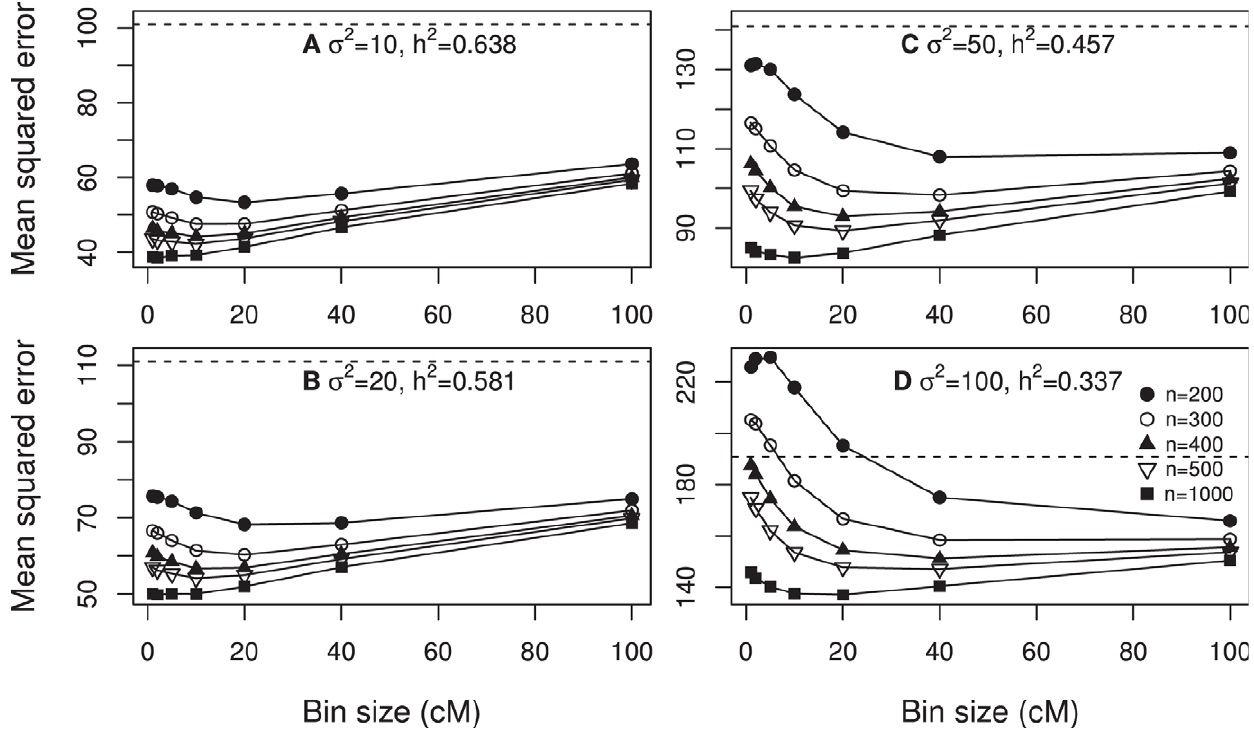
Figure 2. Mean squared error expressed as a function of bin size for design I. The mean squared errors were obtained from 100 replicated simulations. The overall proportion of the phenotypic variance contributed by the 20 simulated QTL was calculated using h 2 ~ 64 : 41 = (64 : 41 z 26 : 53 z s 2 ) . Each panel contains the result of five different sample sizes ( n ). The phenotypic variance of the simulated trait is indicated by the dashed horizontal line in each panel (each panel represents one of the four different